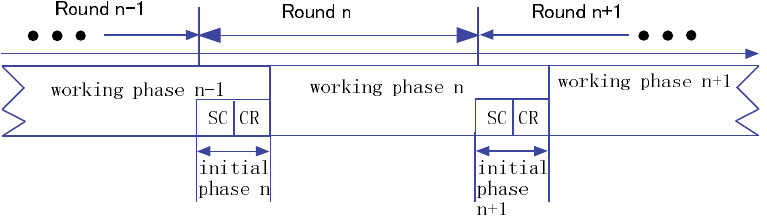
Figure 6. The lifetime of the